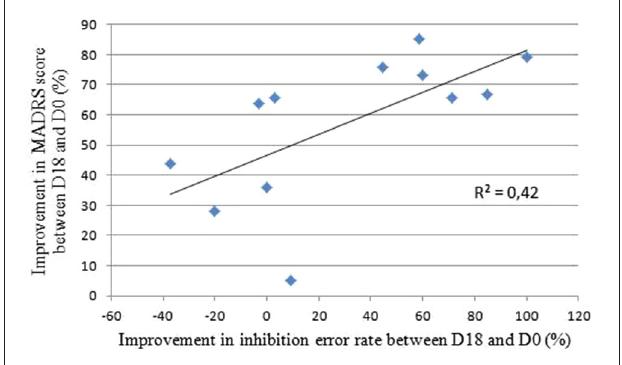
FIGURE 4 | Correlation between the improvements in MADRS scores and inhibition error rate between the end and the beginning of the rTMS treatment. Bravais-Pearson coefficient correlation coefficient equals R = 0.65, p = 0.02 and R 2 = 0.42, where R 2 is the proportion of variance explained by the regression